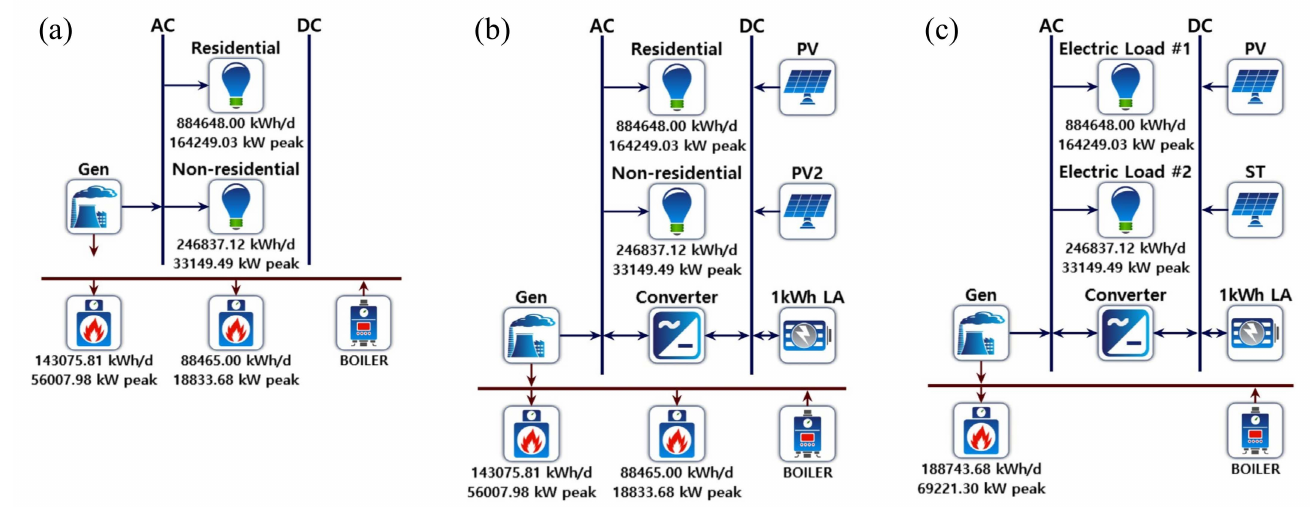
Figure 5. Schematics of simulation cases: ( a ) Base case, ( b ) Case 1, ( c ) Case